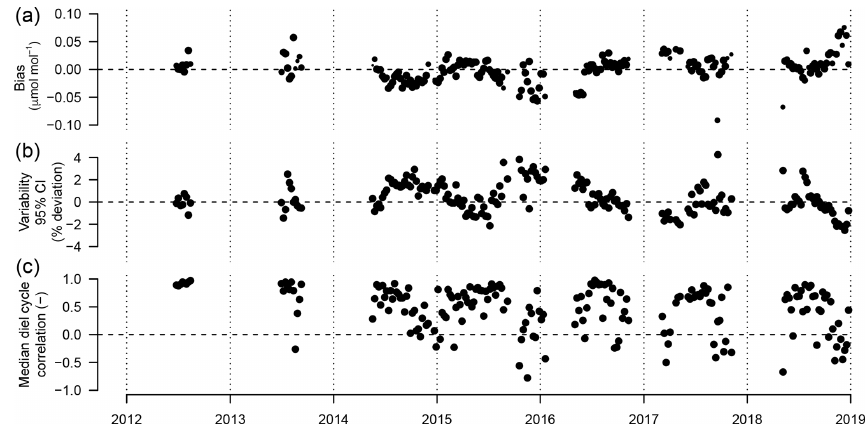
Figure 10. (a) Weekly median bias, (b) median variability, and (c) correlation between weekly median diel cycles of TGS 2600 sensor 1 and the reference. Symbol size is proportional to relative data coverage.